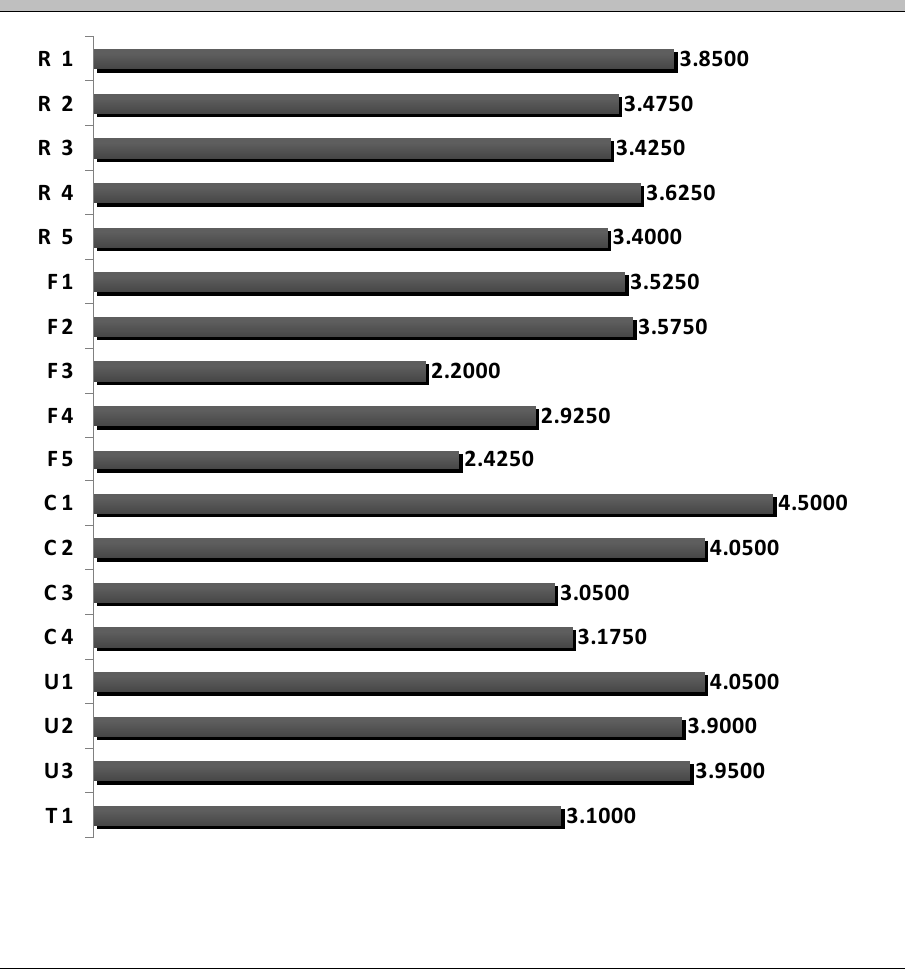
TABLE A2: Summary of mean responses per research